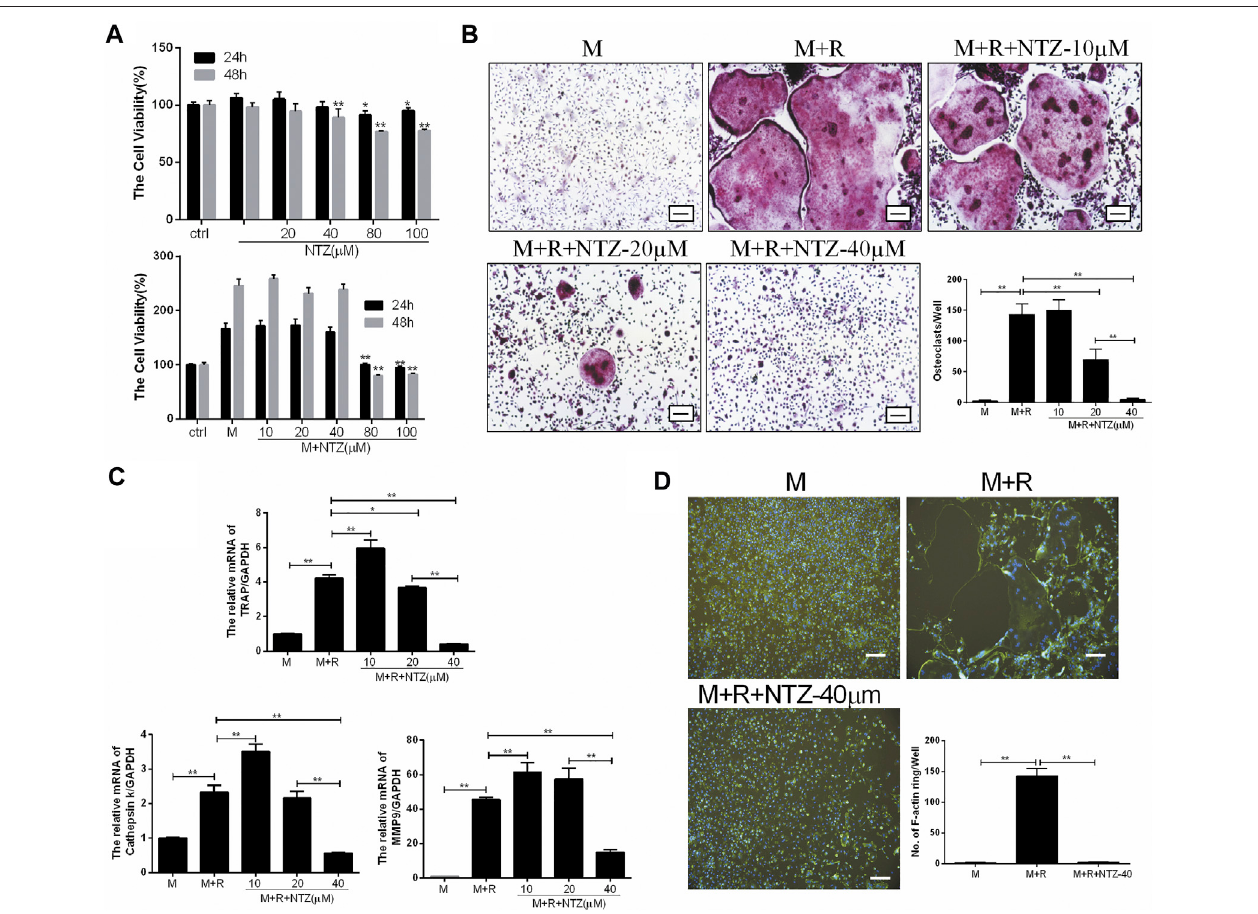
FIGURE 1 | Nitazoxanide inhibited RANKL-mediated osteoclastogenesis in vitro . (A) Cytoactivation of NTZ-treated BMMs at 24 and 48 h with or without M-CSF stimulation was tested by MTS assays. Values of p were compared between experimental group and control group (top) , experimental group and M-CSF group (bottom) . (B) TRAP staining was performed after BMMs treated with various NTZ concentrations, M-CSF (10 ng/ml), and RANKL (50 ng/ml) for 7 days. The number of TRAP-positive multinuclear cells were counted. Scale bar (cid:2) 100 µm. (C) Real-time PCR analyzed the expression of osteoclastic genes including TRAP, Cst K and MMP9. (D) BMMswerestimulatedwithor withoutRANKL (50 ng/ml)inthepresenceofM-CSF(10 ng/ml), followedbytreatment withorwithout40 µMNTZ. Cellswere fi xedandstainedforF-actin.Quanti fi cationoftheactinringwasbypositiveF-actinstaining.Scalebar (cid:2) 100 µm.Errorbarsrepresentmean ± SDfromthreeindependent experiments. ctrl, control; M, M-CSF; NTZ, nitazoxanide; R, RANKL. * p value ＜ 0.05, ** p value ＜ 0.01.